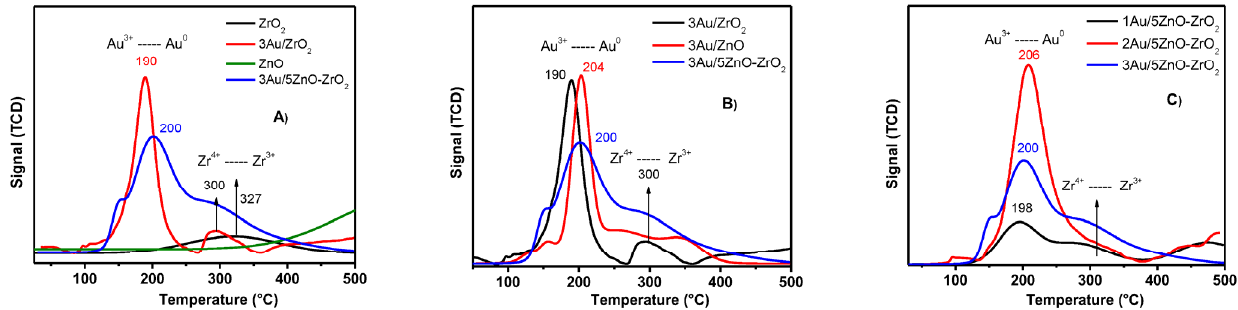
Figure 3. ( A ) Reduction profiles for the ZrO 2 , ZnO, 3Au/ZrO 2 , and 3Au/5ZnO − ZrO 2 catalysts. ( B ) Reduction profiles for the 3Au/ZrO 2 , 3Au/ZnO, and 3Au/5ZnO − ZrO 2 catalysts. ( C ) Reduction profiles for the 1Au/5ZnO − ZrO 2 , 2Au/5ZnO − ZrO 2 , and 3Au/5ZnO − ZrO 2 catalysts.